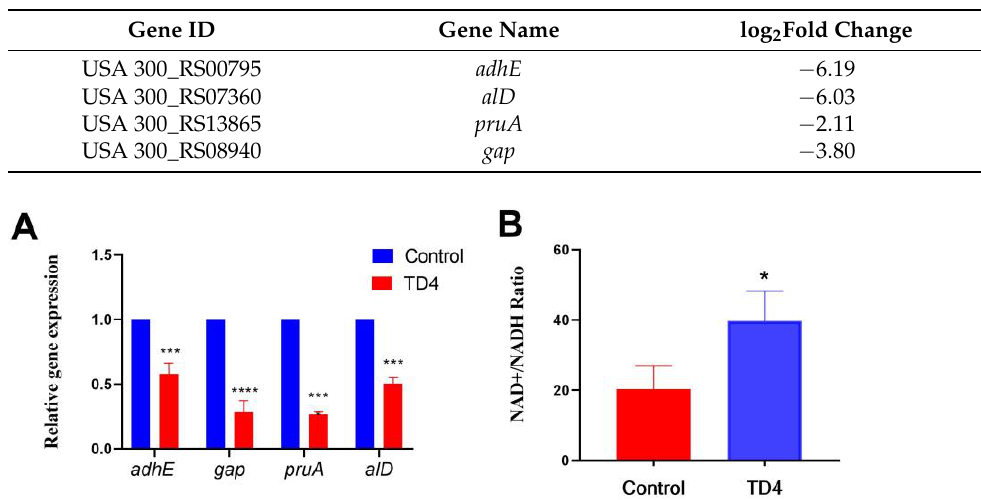
Figure 9. Down-regulated genes and NAD+/NADH ratio after TD4 treatment. The expression of the adhE , gap , pruA , and alD genes after TD4 treatment was measured by RT-PCR, *** p < 0.001, **** p < 0.0001 vs. control group, n = 3 ( A ). NAD + /NADH ratio was measured after TD4 treatment, * p < 0.05 vs. control group, n = 3 ( B ).